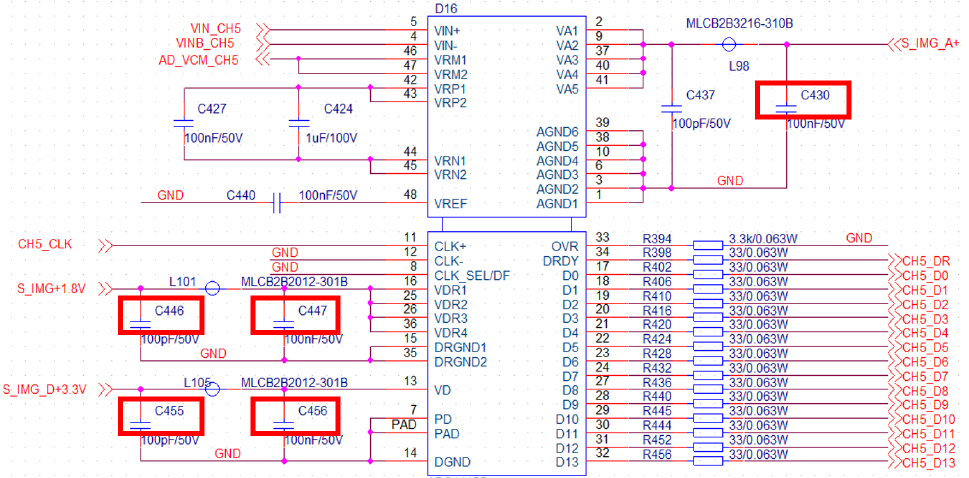
Figure 5. The examples of scattered components in schematic diagram of the circuit. Components in red blocks are scattered after initial